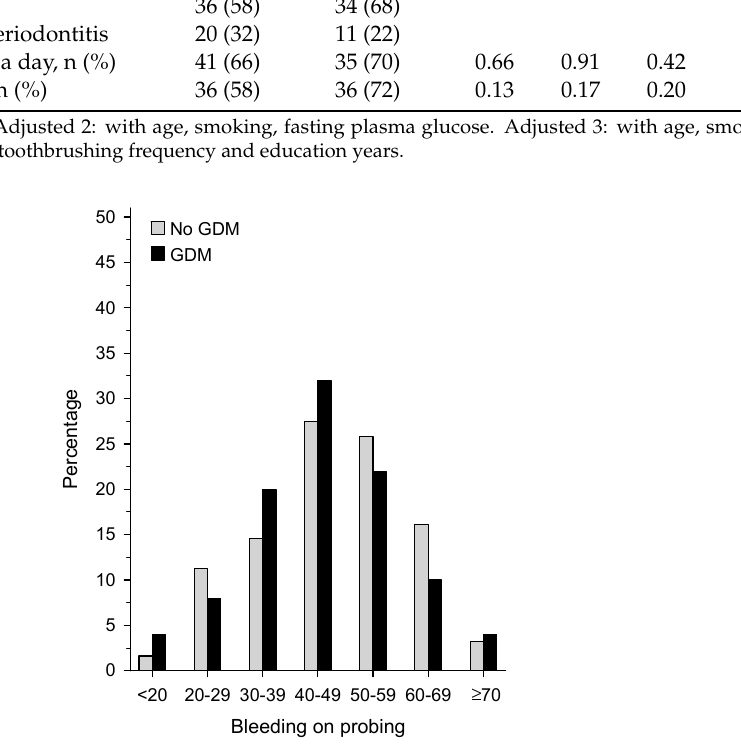
Figure 3. Bleeding on probing (BOP, %) in women without GDM (white bars) and with GDM (dark bars).